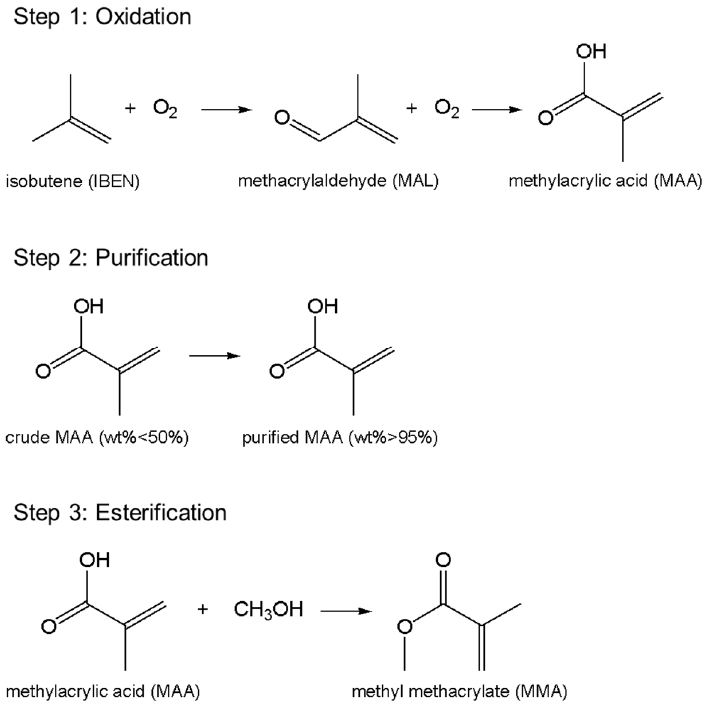
Figure 3. The main steps of C4 direct oxidation method to produce MMA.